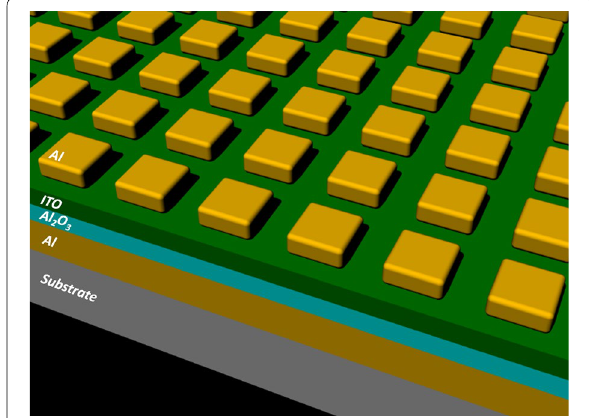
Fig. 1 Schematic of the proposed device. Thickness are: bottom Al mirror, 40 nm; Al 2 O 3 , 15 nm, ITO layer, 15 nm. Top metasurface is composed of square patch nanoantennas that are 20 nm thick with side length of 450 nm, and are set at a pitch of 600 nm. Electrodes are connected between bottom Al and ITO layer to generate an electric field inside the insulator. The incident direction of the light is perpen- dicular to the surface